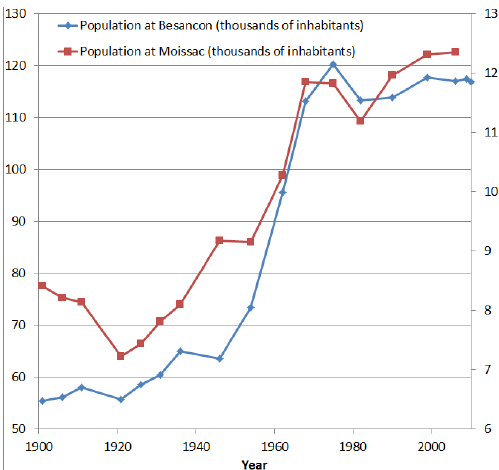
Figure 7. Evolution of the number of inhabitants during the 20th century at Besançon and Moissac. Source: EHESS-Cassini be- fore 1962, INSEE from 1968.